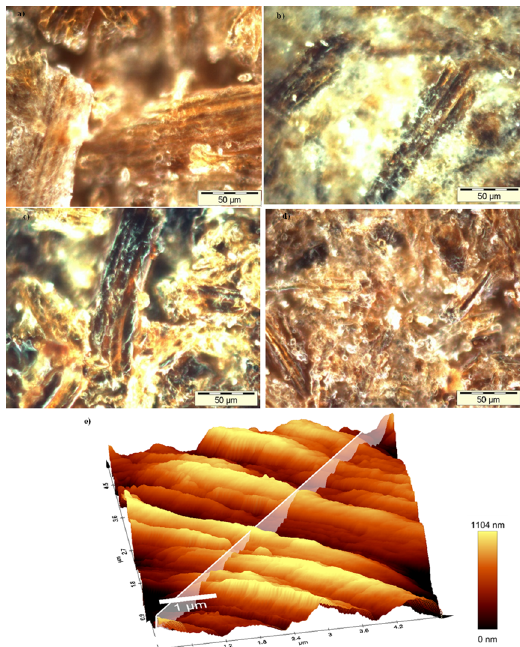
Figure 3. Optical microscopy images of fibers (magnification 50 times): a) "In natura", b) Ca(OH) force micrograph of the surface of a fiber treated with Ca(OH)